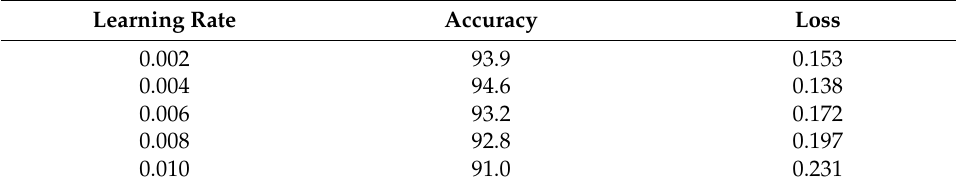
Table 7. Comparison of different learning rates in the Attention-TCN-BiGRU.